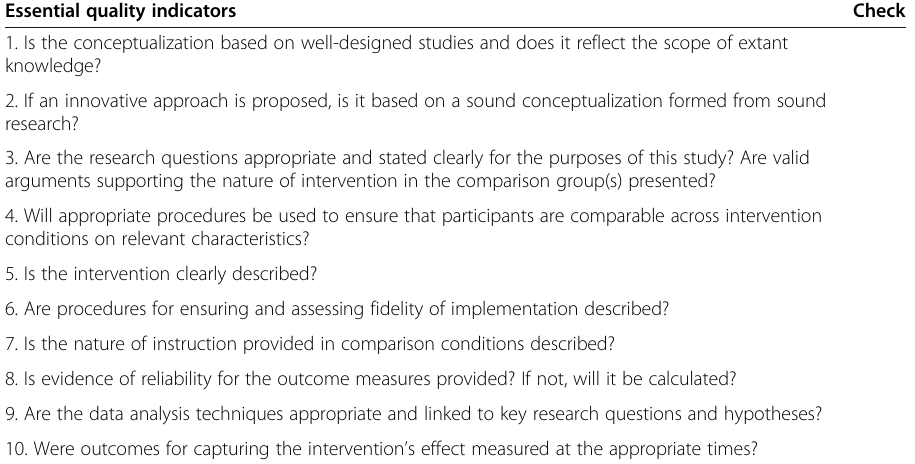
Table 2 The eligibility criteria list adapted from (Gersten et al. 2005) Essential quality indicators Check